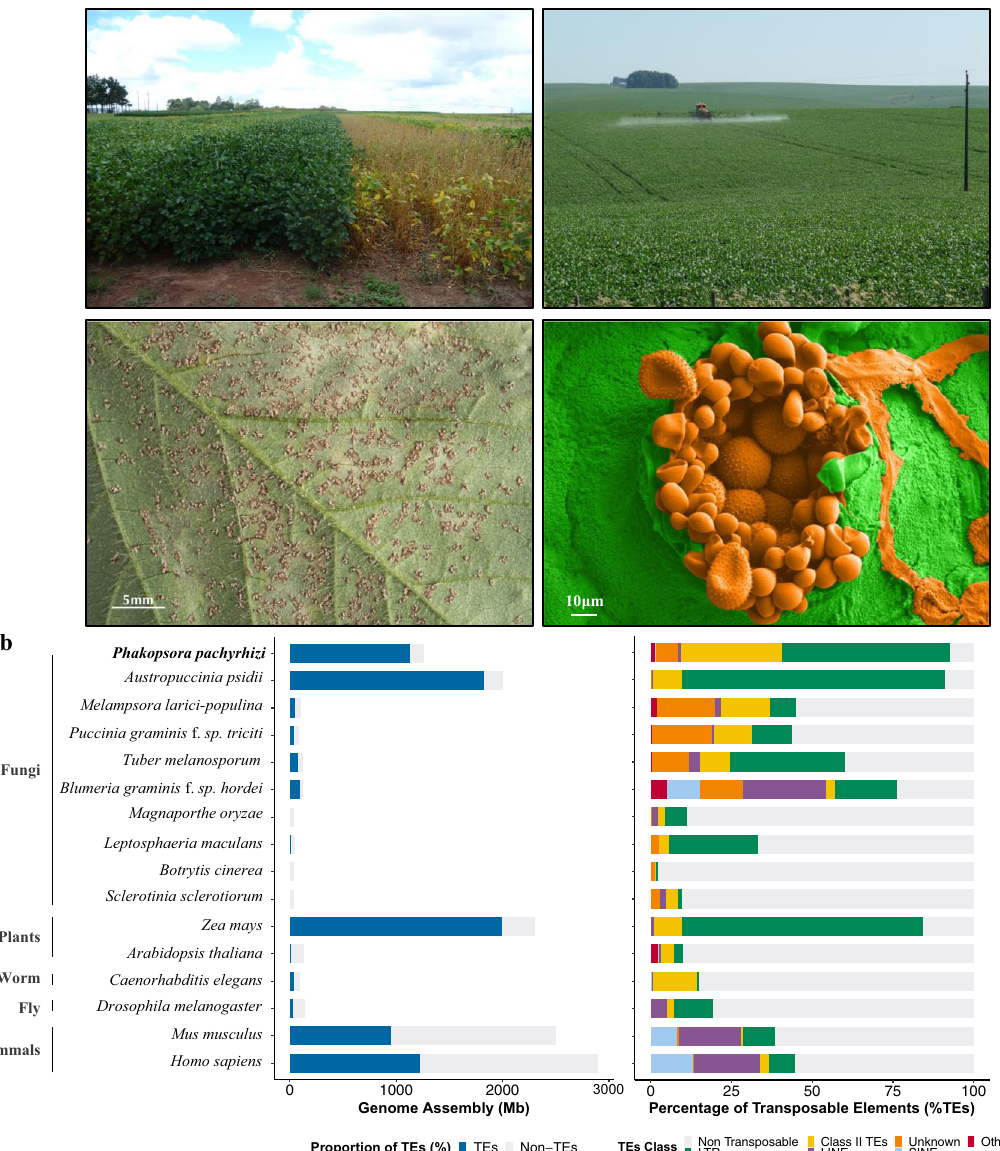
Fig. 1 | Impact of P. pachyrhizi incidence in a soybean fi eld, comparative gen- omeassemblysize,andTEcontent.a Soybean fi eld sprayed with fungicide (left) and unsprayed (right) in Brazil (top left). Soybean fi eld being sprayed with fun- gicide(topright).Soybeanleafwithahighlevelof P.pachyrhizi urediospores,Tan lesions (bottom left). Electron micrograph of P. pachyrhizi infected leaf tissue, showing paraphyses and urediospores highlighted in pseudo-color with orange,